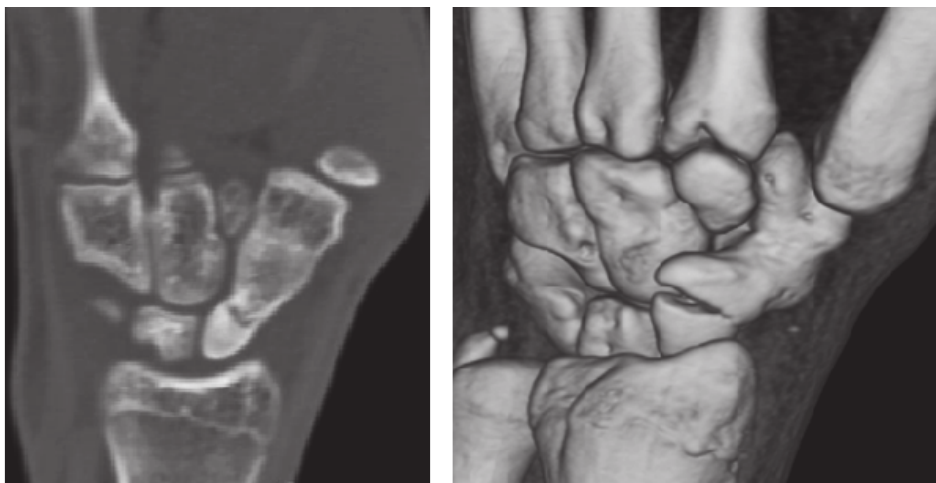
Figure 2: CT scan shows complete Scaphotrapezial synostosis with scaphoid waist fracture.